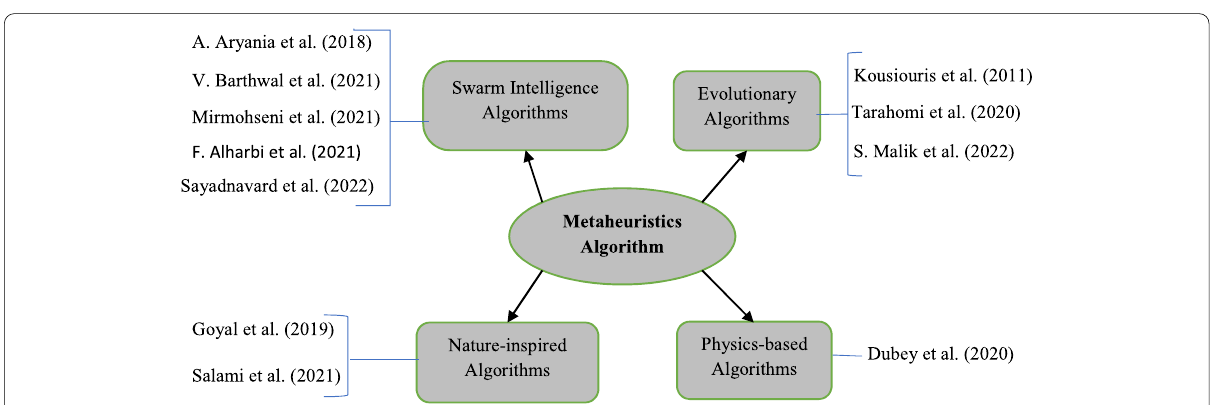
Fig. 7 Classification of existing research using the Metaheuristic